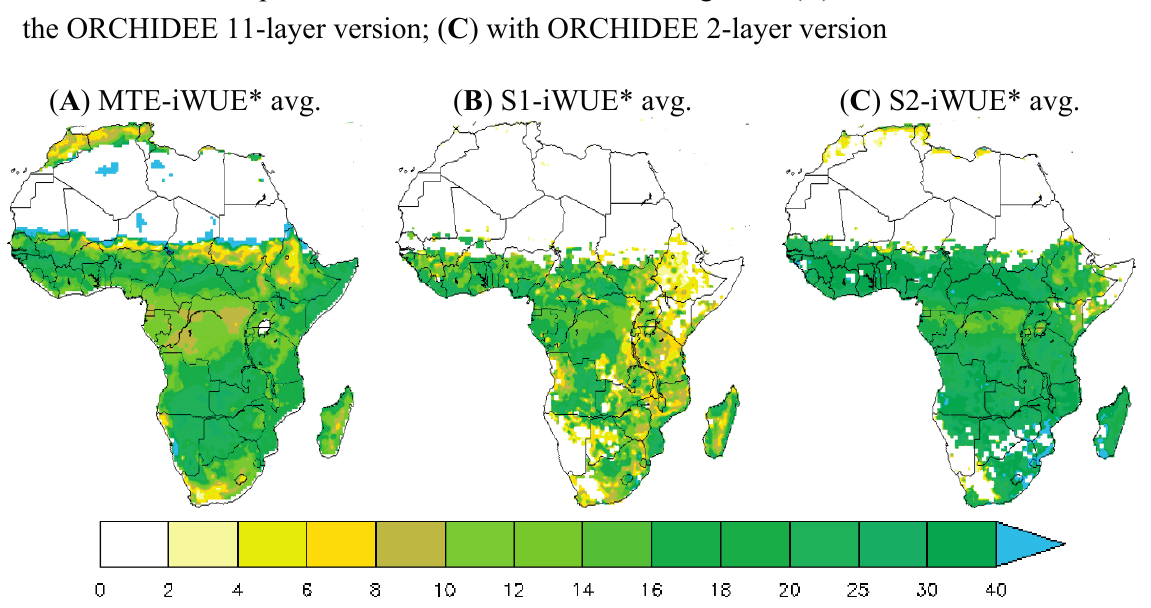
Figure 1. 1982–2010 iWUE* average ( gC · hPa · mm (cid:2879)(cid:2869) · m (cid:2879)(cid:2870) ). ( A ) iWUE* calculated from MTE-GPP and ET products and WFDEI climate forcing data; ( B ) iWUE* simulated